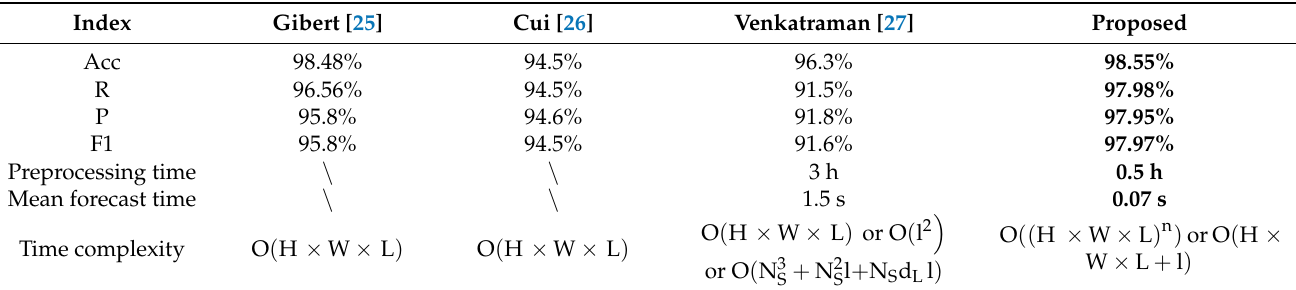
Table 6. Comparison with other scholars’ malware family classification